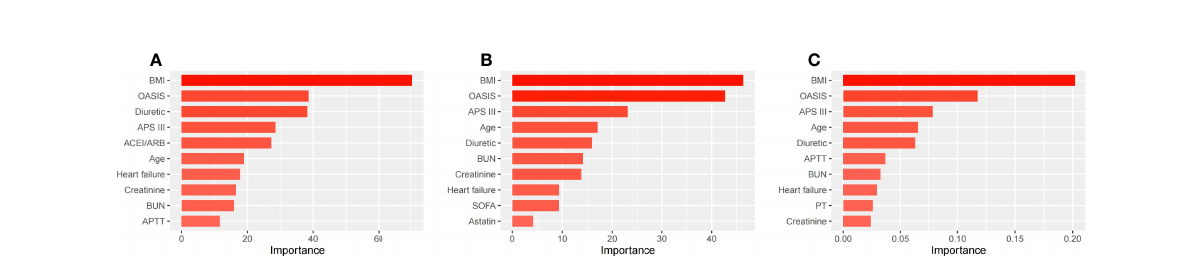
FIGURE 5 The top ten important factors of SA-AKI for men in the decision tree model (A) , random forest model (B) and extreme gradient boosting model (C) . Models were adjusted for all variables, including age, BMI, ethnicity, admission type, hypertension, coronary atherosclerosis, heart failure, diabetes mellitus, COPD, cerebral infarction, chronic liver disease, chronic kidney disease, tumor, APS III, OASIS, SOFA, heart rate, MAP, RR, temperature, SpO2, WBC, hemoglobin, platelet, PH, bicarbonate, BUN, creatinine, potassium, sodium, chloride, glucose, PT, APTT, lactate, vasopressor use, mechanical ventilation use, diuretic, aminoglycoside, statin, ACEI/ARBs. ACEI/ARBs, Angiotensin-converting enzyme inhibitors/ angiotensin receptor blockers; AKI, Acute kidney injury; APS III, Acute Physiology Score III; APTT, Activated partial thromboplastin time; BMI, Body mass index; BUN, Blood urea nitrogen; COPD, Chronic obstructive pulmonary disease; OASIS, Oxford Acute Severity of Illness Score; PT, Prothrombin time; SA-AKI, Sepsis associated acute kidney injury; SOFA, Sequential Organ Failure Assessment; RR, Respiratory rate; WBC, White blood